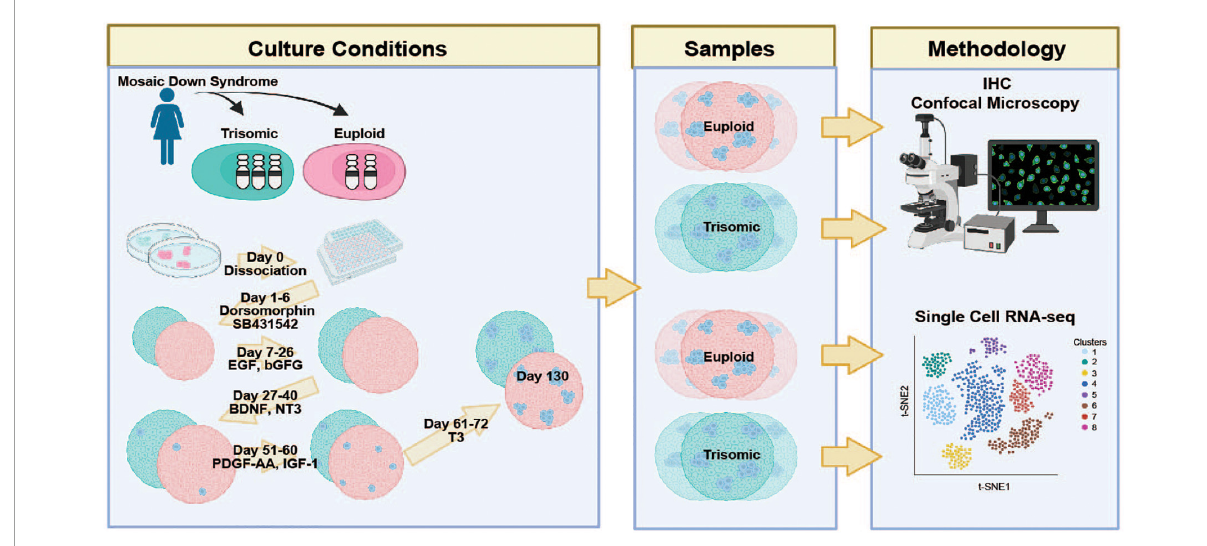
FIGURE1 Schematic representation of the experimental protocol and study design Isogenic HSA21 euploid (red) and trisomic (blue) induced pluripotent stem cell (iPSC) lines derived from a woman with Down Syndrome were differentiated into cortical spheroids (CS) and analyzed at day 130 via IHC and scRNA-seq. Created with